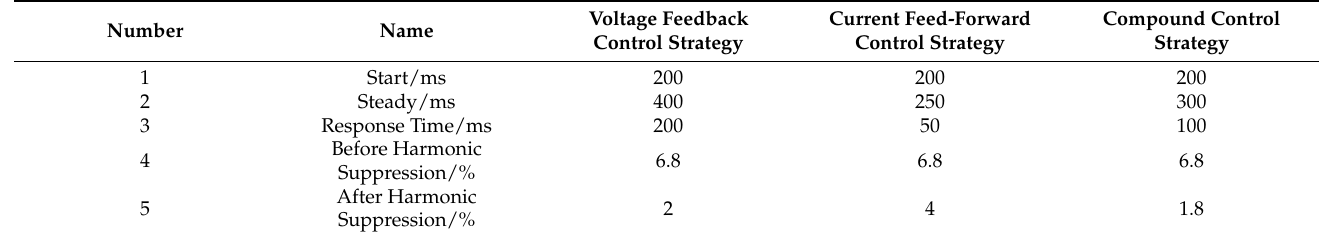
Table 2. Comparison of harmonic suppression effect and response time.